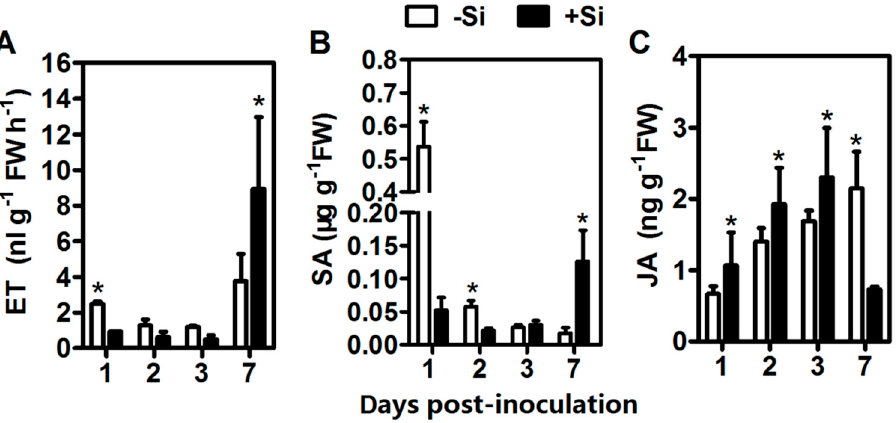
Figure 2. Hormone measurements of silicon (Si)-treated (+Si) and non-Si-treated ( − Si) tomato plants after infection. ( A ) ET production. ( B ) SA content. ( C ) JA content. FW: fresh weight. Data presented are means ± standard error (SE) of three replicates. Asterisks denote a significant difference between treatments at the same time-point (Student’s t -test, p < 0.05).